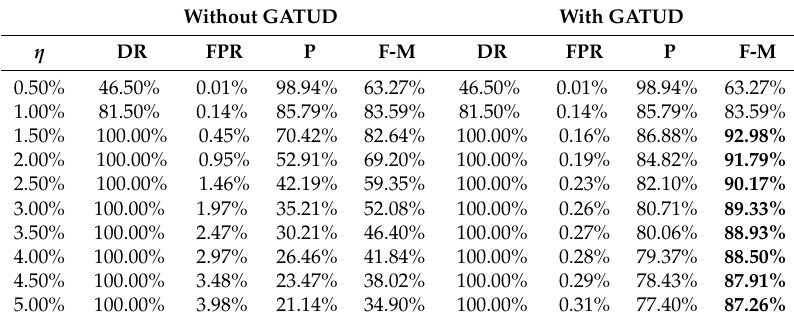
Table 4. The separation accuracy of abnormal observations with/without GATUD on SimData2.